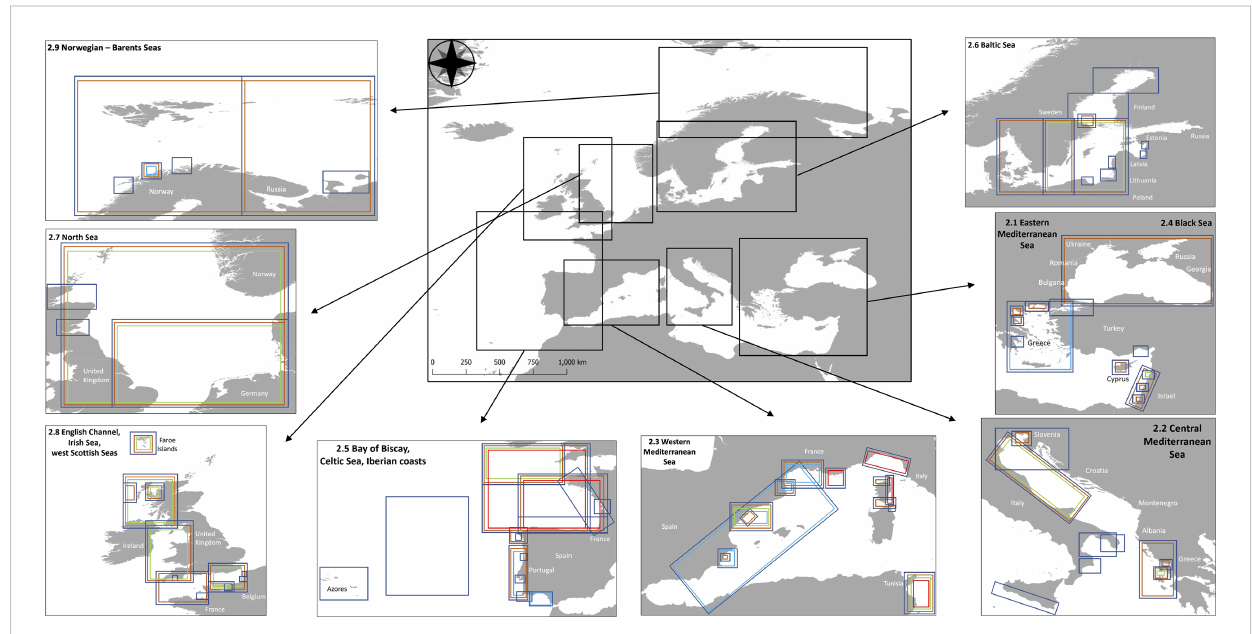
FIGURE 1 Map showing the nine European marine regions considered in this review. Colored rectangles encompass the approximate area modelled with EwE in all nine regions, including Ecopath models (blue rectangles), Ecosim models (orange rectangles), Ecospace models (green rectangles), EcoTroph models (red rectangles), and ECOIND plug-in expansions (light blue